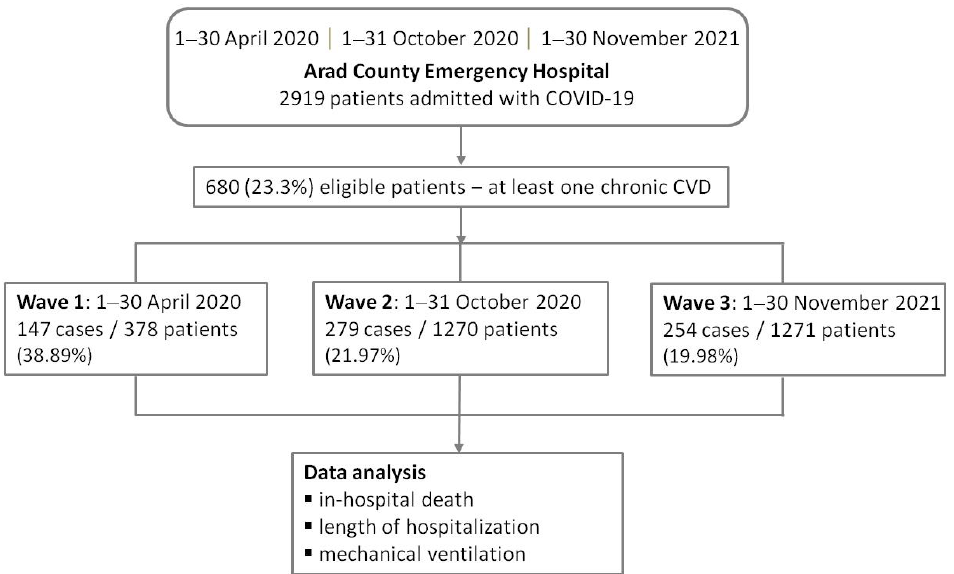
Figure 1. Study flow diagram. Abbreviation: CVD, cardiovascular disease.